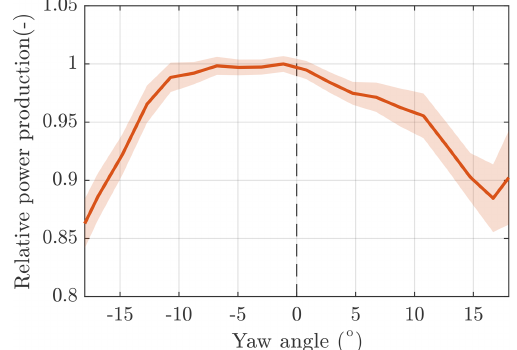
Figure B1. Relationship between the normalized power produc- tion and the yaw misalignment angle for an arbitrary GE 1.5s wind turbine on the Sedini wind farm. The data were collected for the range of 6 to 12ms − 1 wind speeds. The asymmetry is clearly seen. Moreover, negative yaw misalignment shows a much smaller loss or even a very slight gain in power production compared to positive yaw